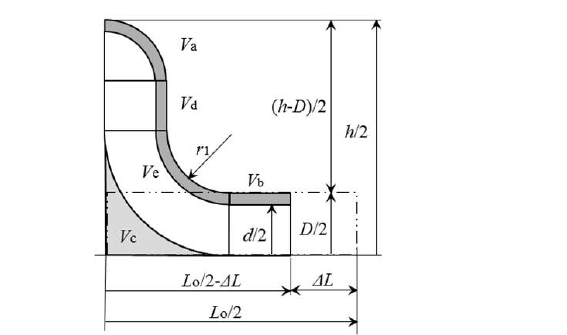
Figure 26. Model of geometric relationship between bulge height h and amount of axial feeding Δ L in MTHF process.